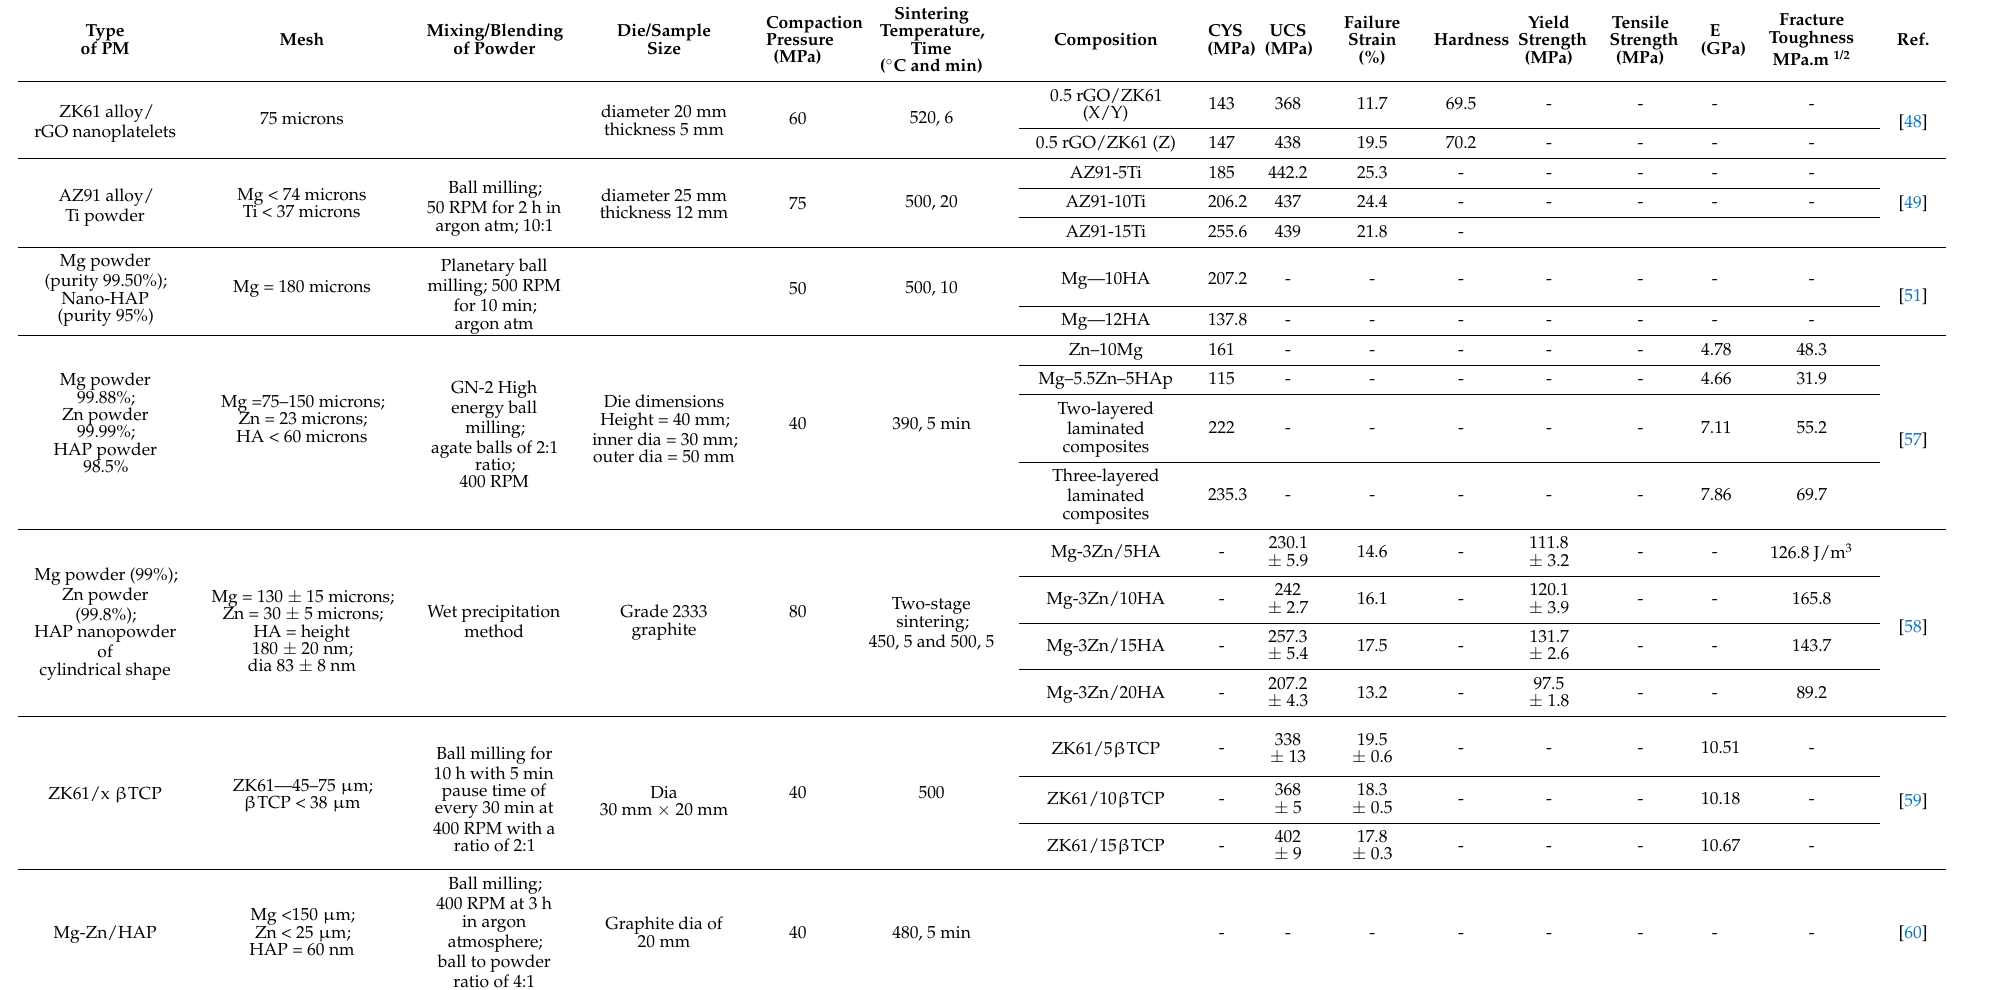
Table 2. Mechanical properties of spark plasma-sintered Mg